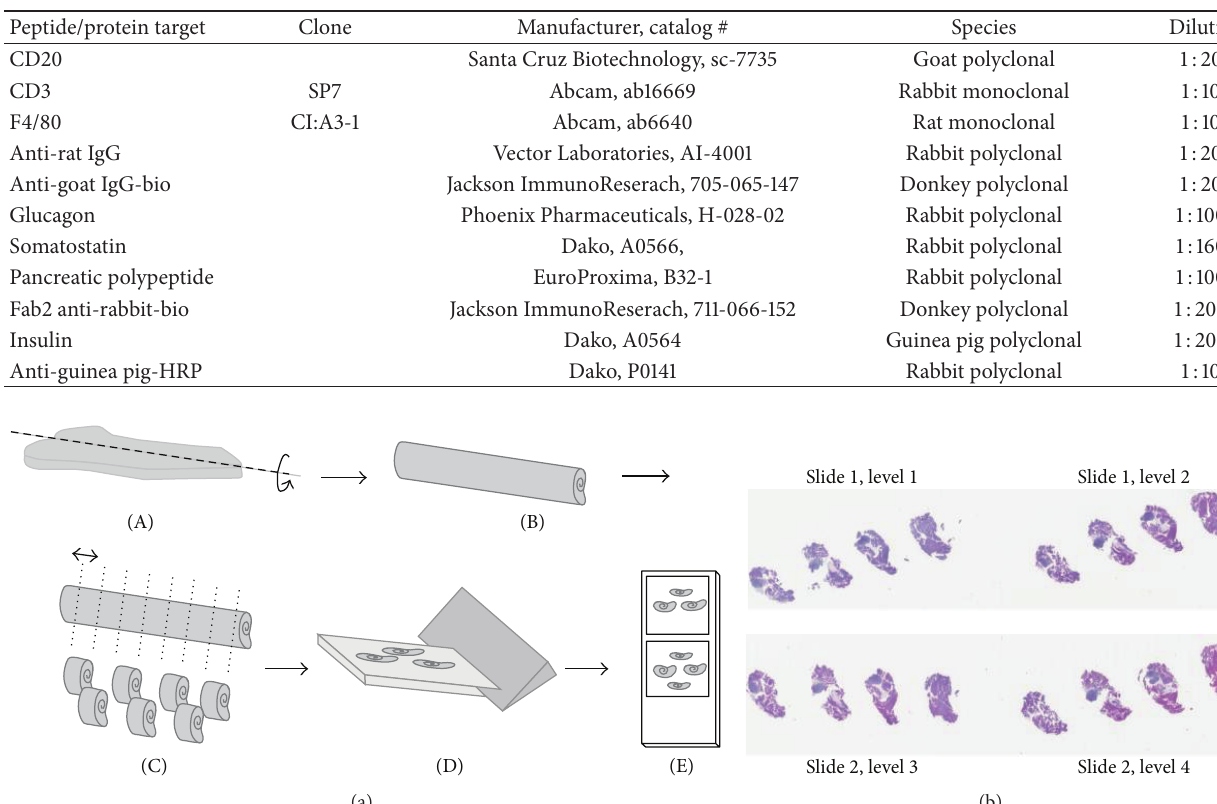
Table 1: List of antibodies.